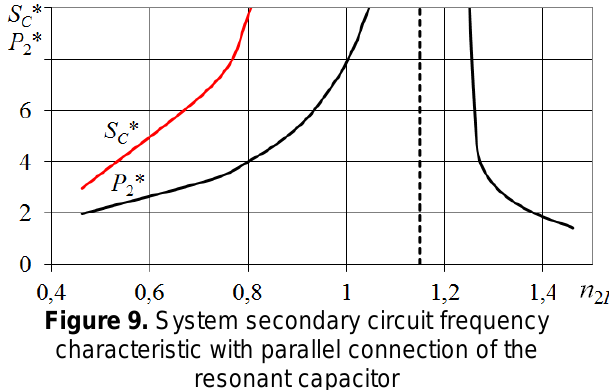
Figure 9. System secondary circuit frequency characteristic with parallel connection of the resonant